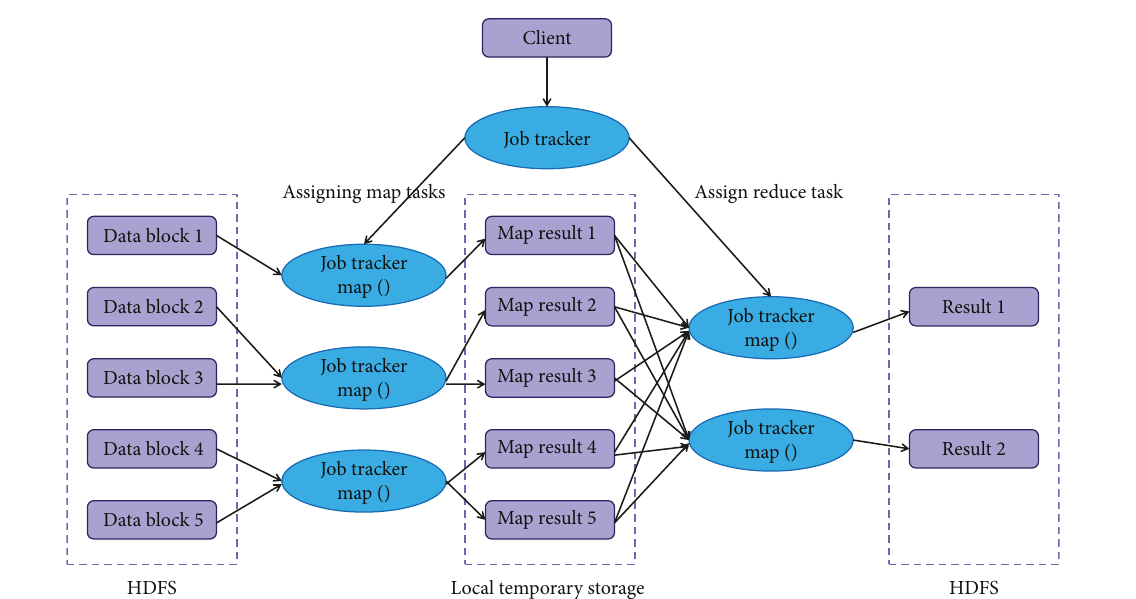
Figure 4: Distributed MapReduce computation